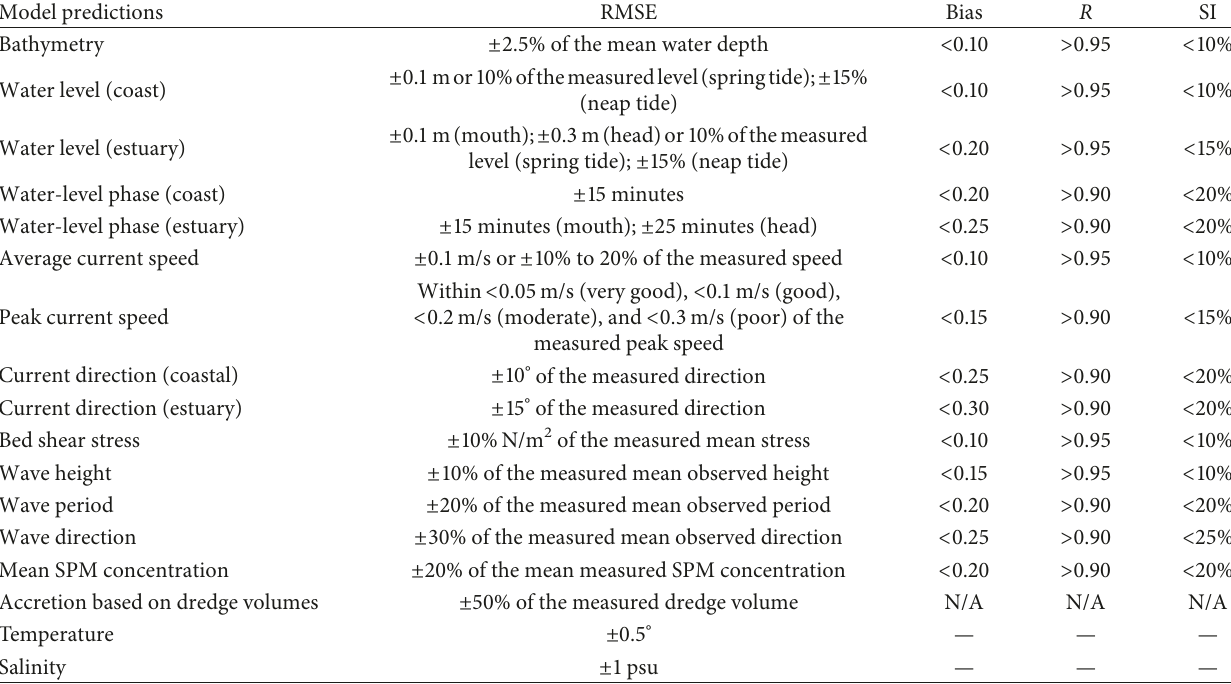
Table 7: Statistical guidelines to establish calibration standards for a minimum level of performance for coastal and estuarine hydrodynamic and sediment models. The table is based in part on the recommendations from Evans [1] and Bartlett [2]. Model predictions RMSE